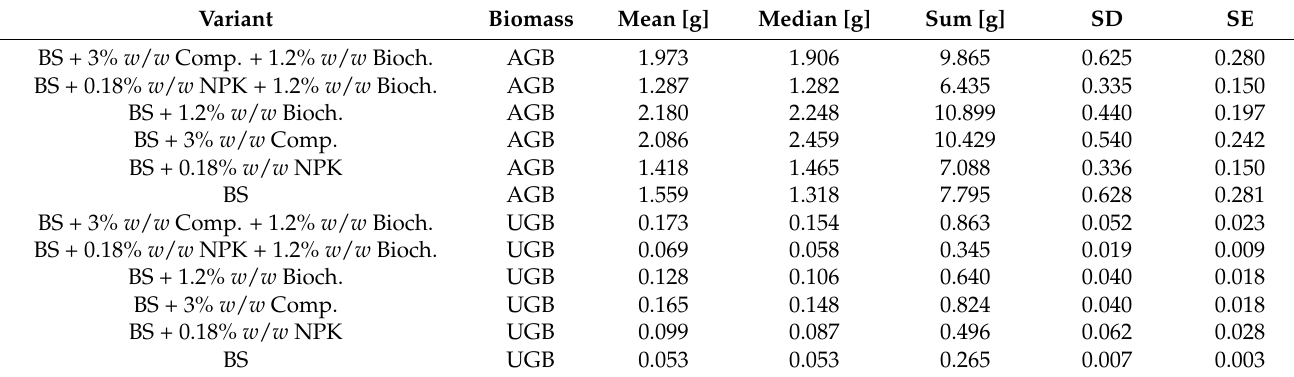
Table A2. Descriptive statistics of AGB and UGB weight of D.M.